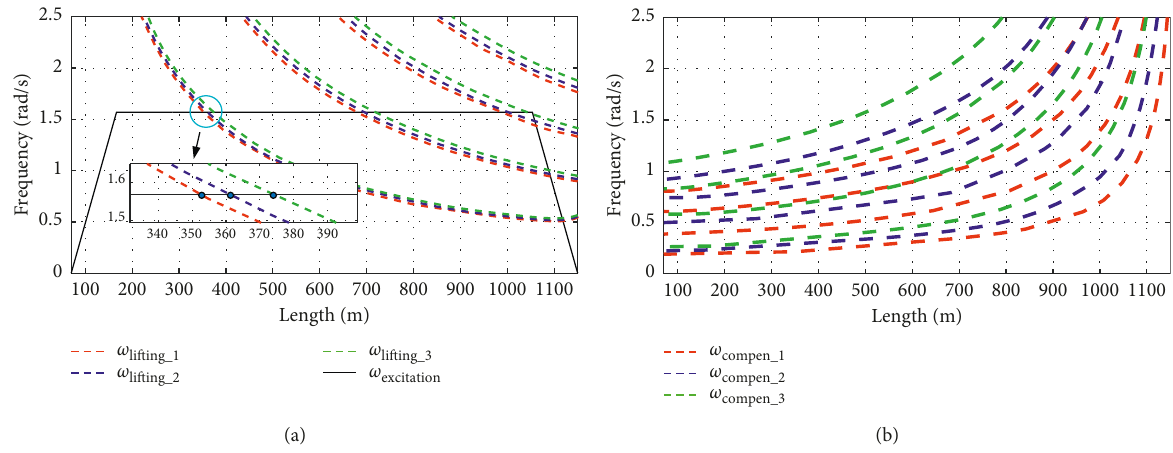
Figure 24: Variations in the transverse natural frequencies of the lifting and compensating rope, where ω frequency of the lifting rope, ω is the transverse natural frequency of the compensating rope, and ω compen − 1 , 2 , 3 frequency in the transverse direction.